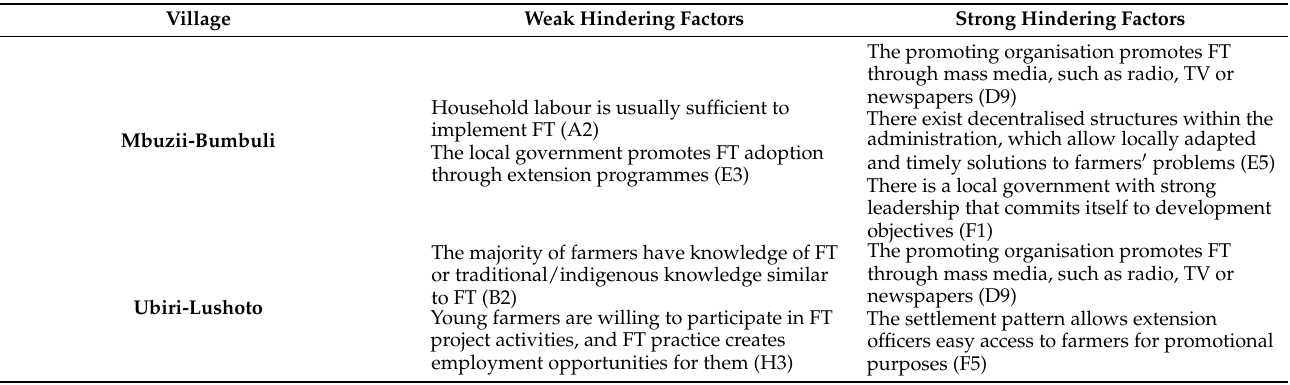
Table 2. Strong and weak hindering factors for the adoption of improved forage technologies 1